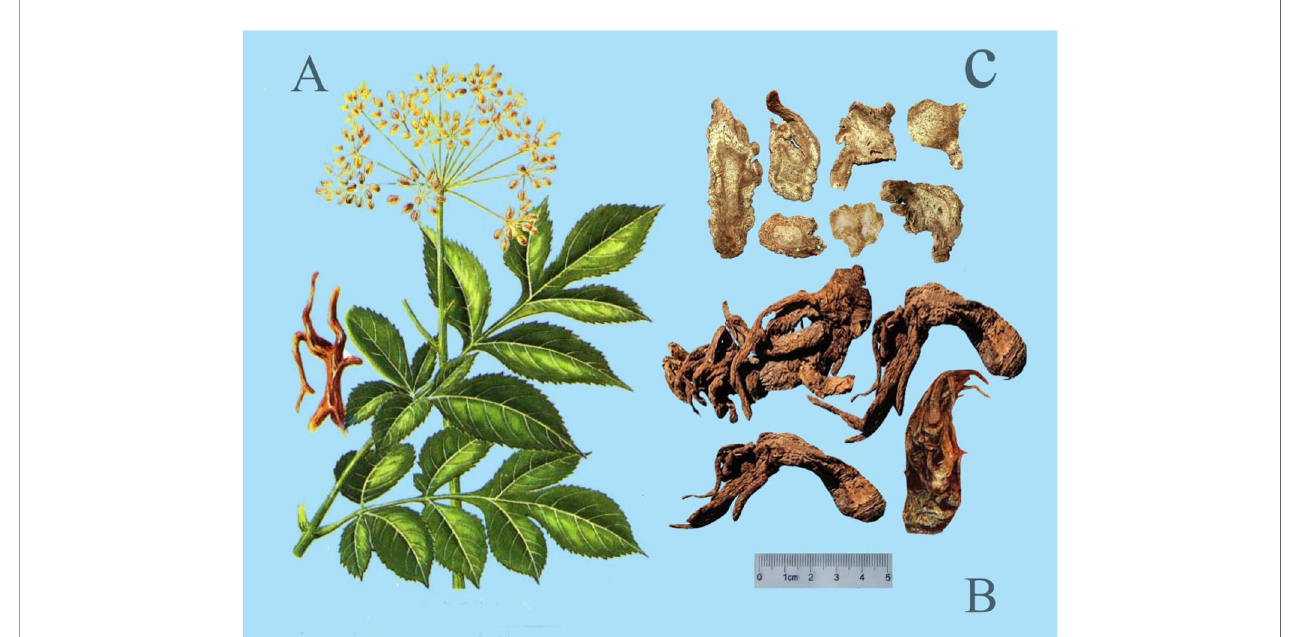
FIGURE 1 | The whole plant of A. biserrata (A) , medicinal parts of APR (B) , the processed of APR (C) .